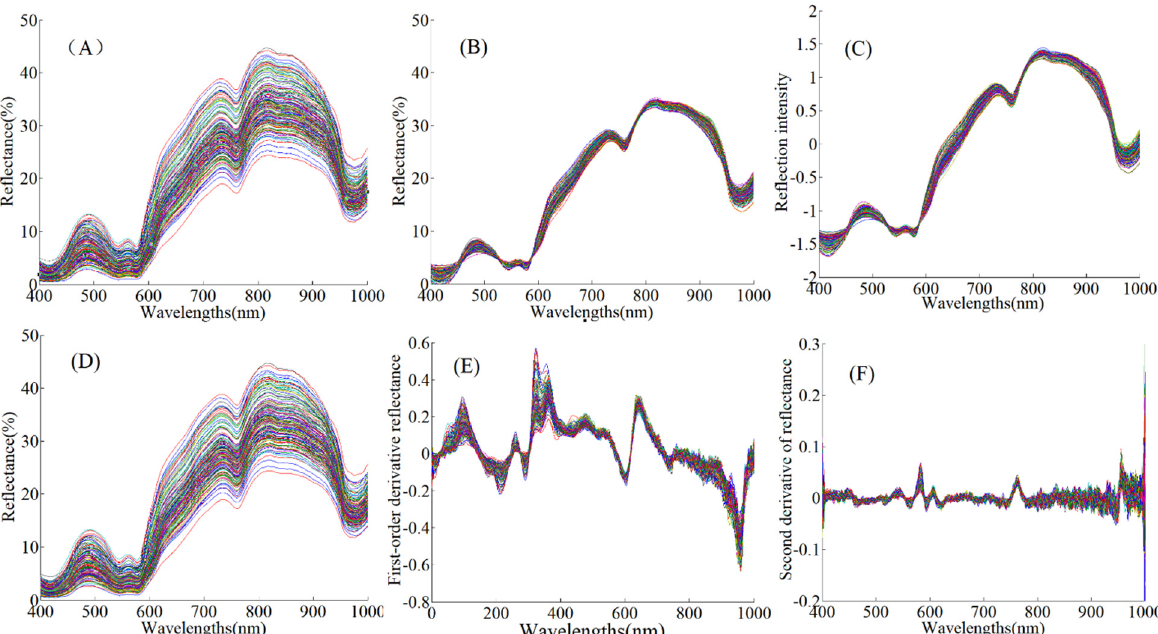
Figure 2. ( A ) Original spectra of all samples. ( B ) The spectra after MSC preprocessing. ( C ) The spectra after SNV preprocessing. ( D ) The spectra after S–G smoothing. ( E ) The spectra after S–G smoothing + 1st Der (5 points) preprocessing. ( F ) The spectra after S–G smoothing + 2nd Der (5 points) preprocessing.